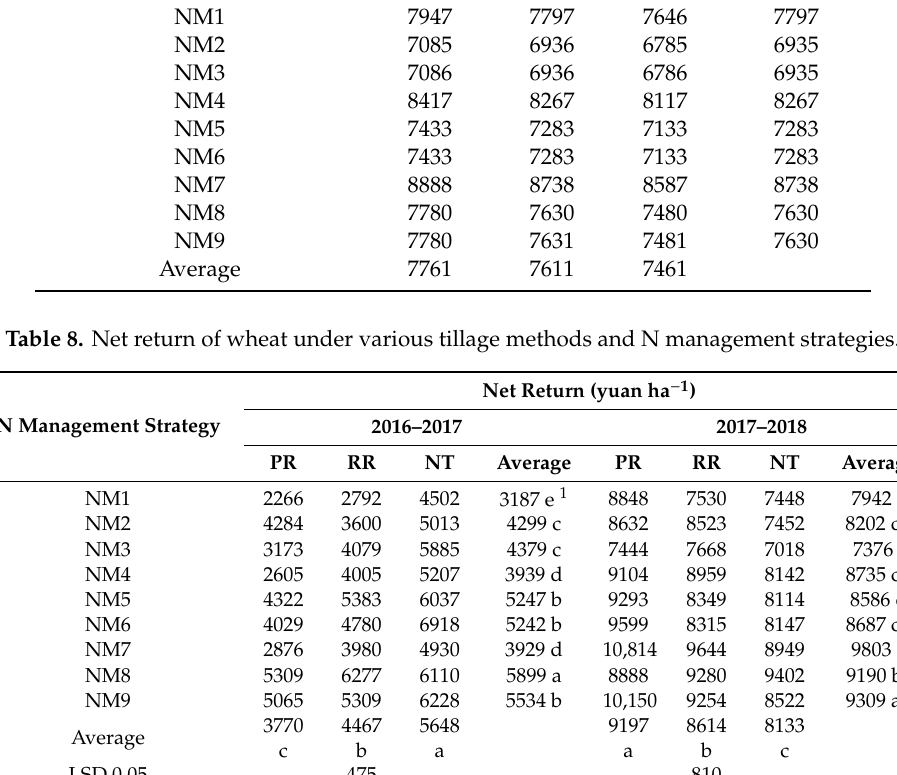
Table 7. Total cost of production under various tillage methods and N management strategies.